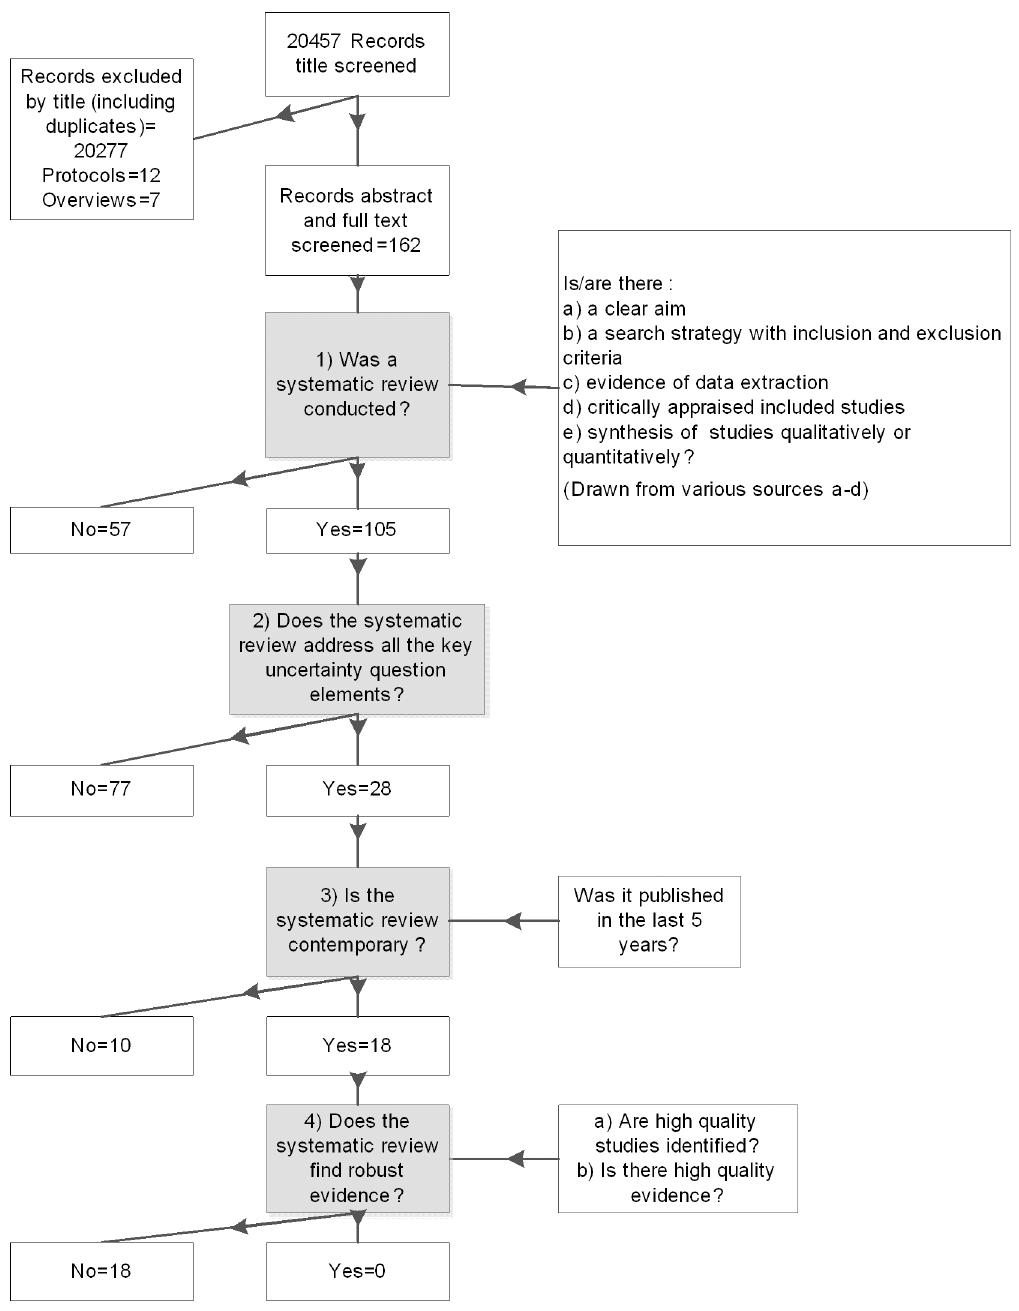
Fig 1. Evaluation process and criteria. We present the total number of review records screened, the four criteria used for screening abstracts/full papers, and the number of reviews meeting/not meeting each criterion. a,NHS centre for reviews